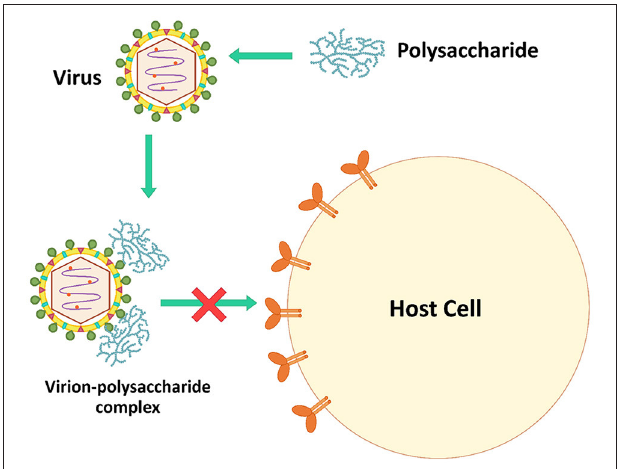
FIGURE 2 | The inhibition mechanism by directly inactivating virus.